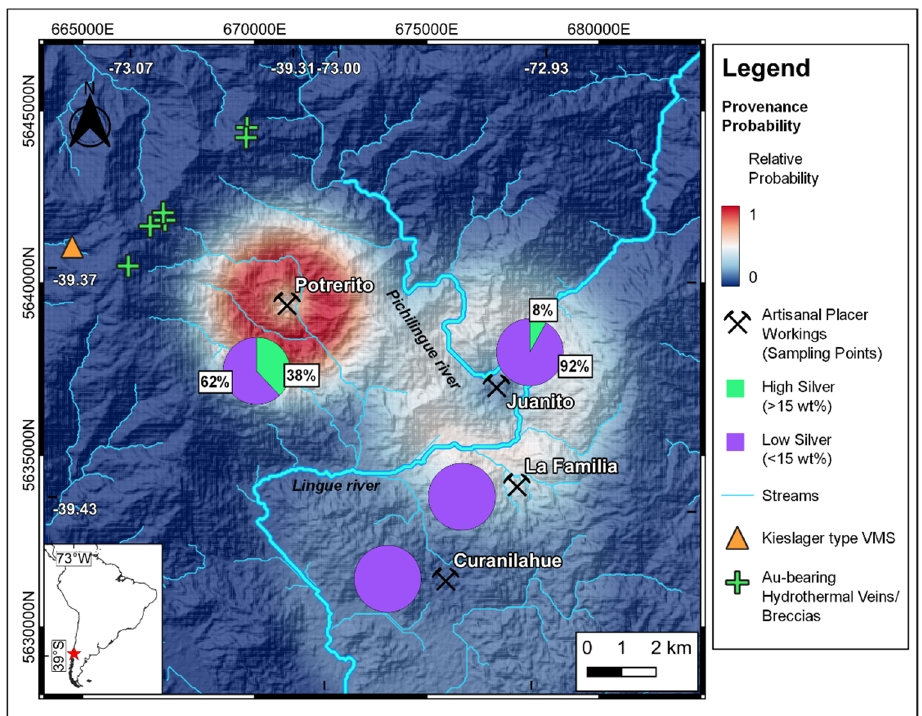
Figure 10. Relative probability (values normalized between 0–1) of provenance according to particle morphology quantified by HSE distributions and distance estimated using [30] shape–distance models for Klondike placers. Probability was weighted with the number of samples recovered in each site and normalized, obtaining a relative probability. Proportions of compositional sub-populations occurring in the placers and hypogene mineralizations are shown.